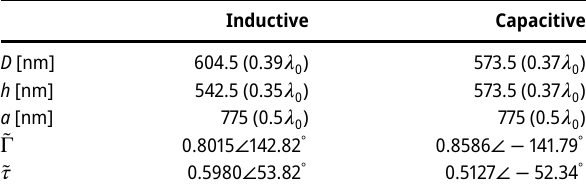
Table 1: Nanodisks dimensions (diameter D = 2 r , height h , and period a ) of the inductive and capacitive metasurfaces with the most significant digit with respect to the design wavelength 𝜆 0 = 1550 nm. It is also ̃ Γ coefficients produced by a included the transmission ̃𝜏 and reflection single metasurface at the design frequency f 0